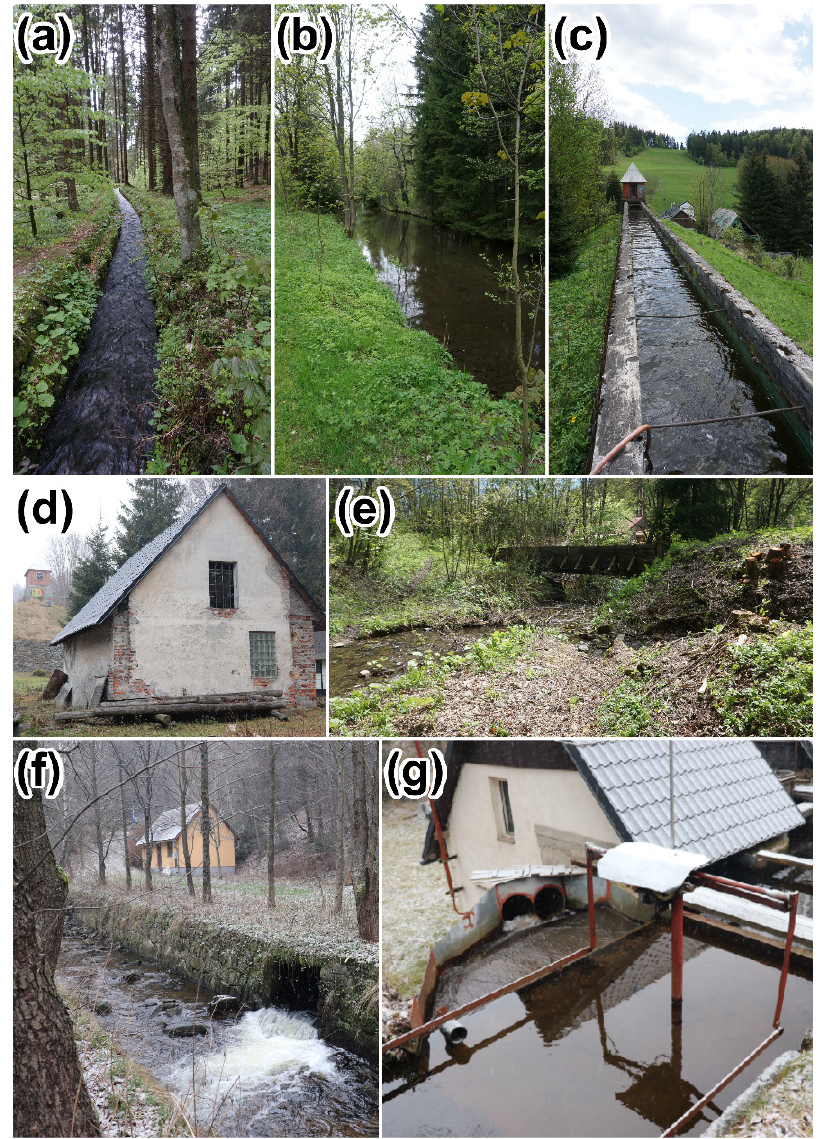
Figure 10. The water management components in Star á Ves: ( a ) the raceway from Stˇr í brn ý creek towards the reservoir ( b ), from which the water is conducted through a concrete raceway ( c ) in the direction of Ann’s melter power plant ( d ); ( e ) the flume of the lower raceway, crossing Stˇr í brn ý creek and taking the water towards the waterpower plant ( f ); and ( g ) the lowermost waterpower plant at the former Ferdinand‘s